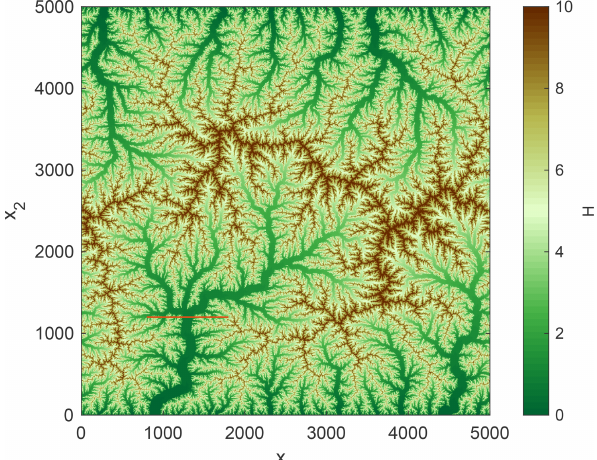
Figure 5. Topographic profiles along the lines depicted in Figs. 3 and